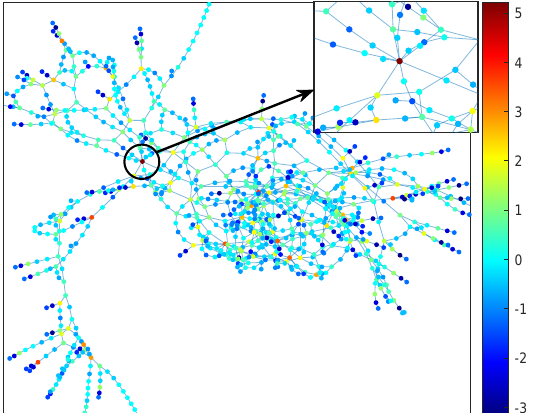
Figure 10. It shows how each vertex affects the robustness of the European road network, where these vertices are measured using Modified Zagreb Index Centrality and then colored depending on the values. One of the vertices evaluated as important is enlarged in the inset.